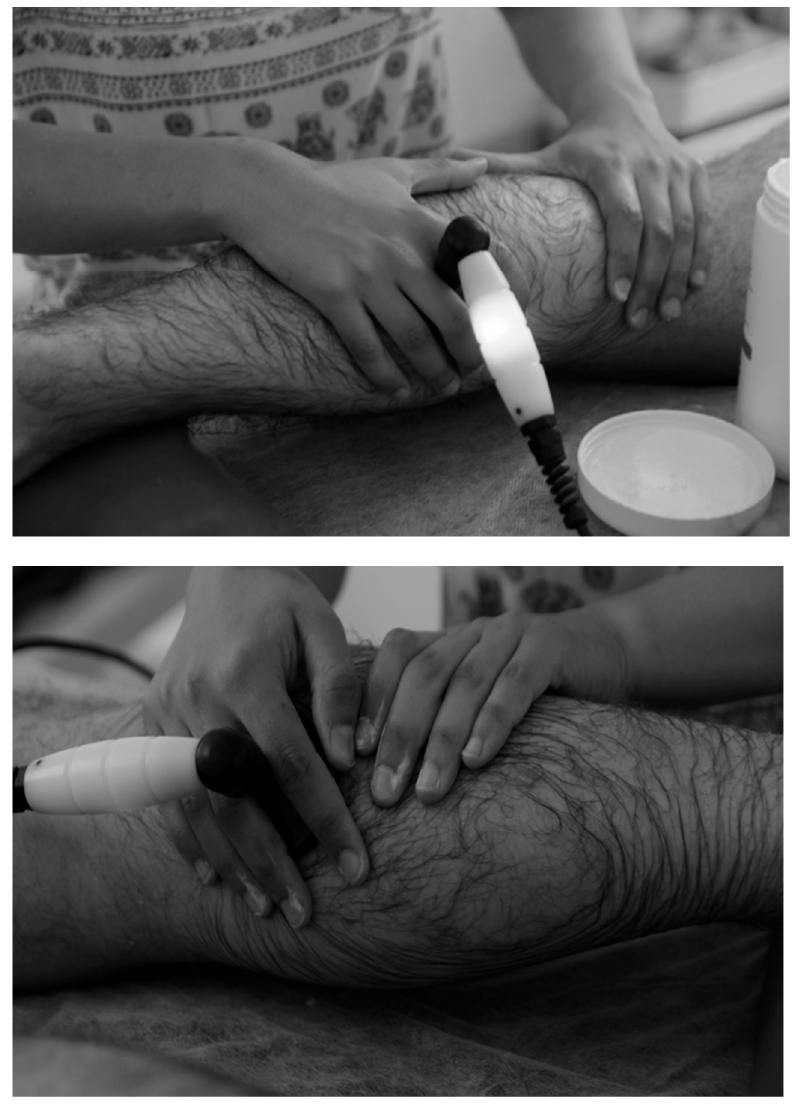
Figure 2. Patient in comfortable prone position, adhesive electrode on anterior tibial area (10 × 15 cm). Therapist’s hand holding the capacitive head. Therapist’s hand holding the resistive head. Prepared by the authors.